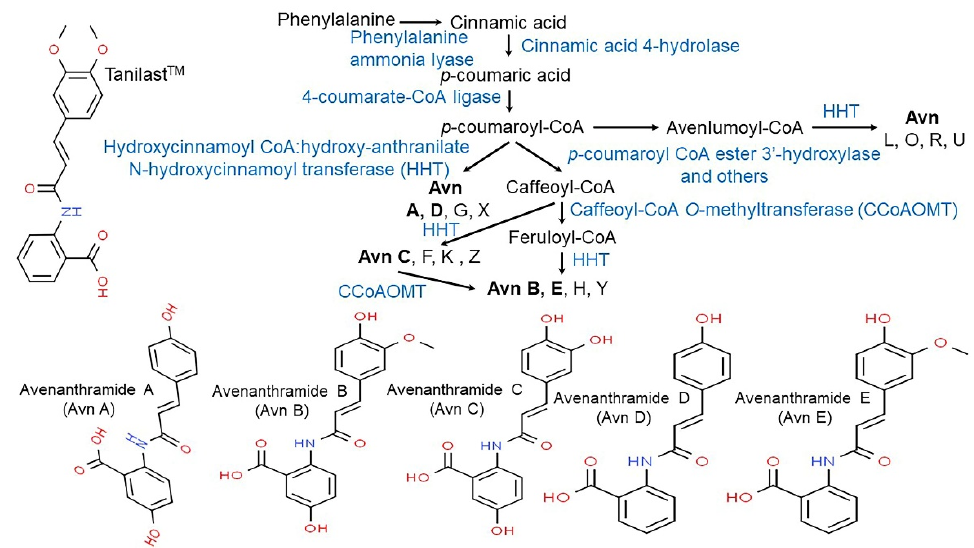
Figure 7. Proposed biosynthetic pathway of major avenanthramides in oat ( Avena sativa L.) [9,94,95].